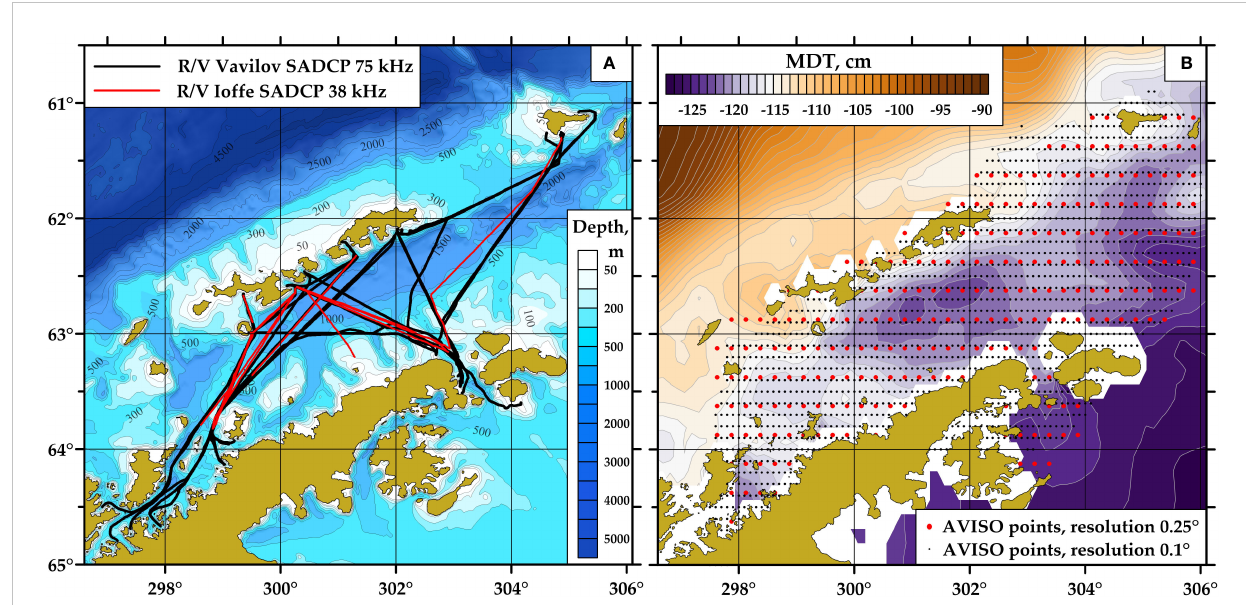
FIGURE 3 Distribution of in situ measurements (A) and AVISO data points (B) in the Brans fi eld Strait. Locations of the SADCP sections used in this study are indicated with black (measurements from the R/V Akademik Sergey Vavilov) and red (measurements from the R/V Akademik Ioffe) lines. Bathymetry is shown according to the GEBCO2019 database. The black and red dots denote locations of altimetry data points of 0.25° and 0.1° resolution, respectively; the mean sea level according to the MDT data is shown by the color scale in panel (B)